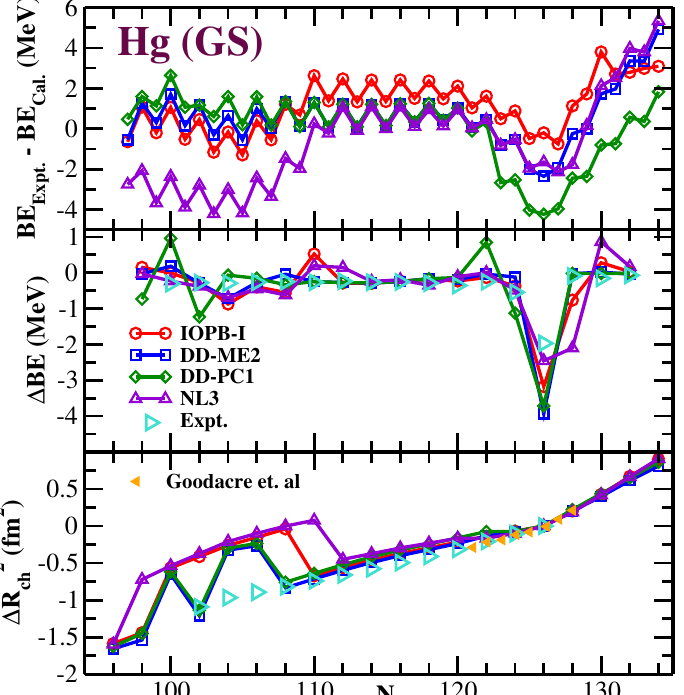
Figure 2. (Color online) The binding energy deviation ( BE Expt . - BE Cal . ), the isotopic shifts of binding energy (BE) and charge distribution radius ( R ch ) in fm are shown in the upper, middle and lower panels respectively for the ground state of Hg-isotopes. The available experimental data are given for comparison [51,52]. The predictions by Goodacre et al. [9] for the isotopic shift at N = 126 are also given for comparison. The energies are in MeV and radius in